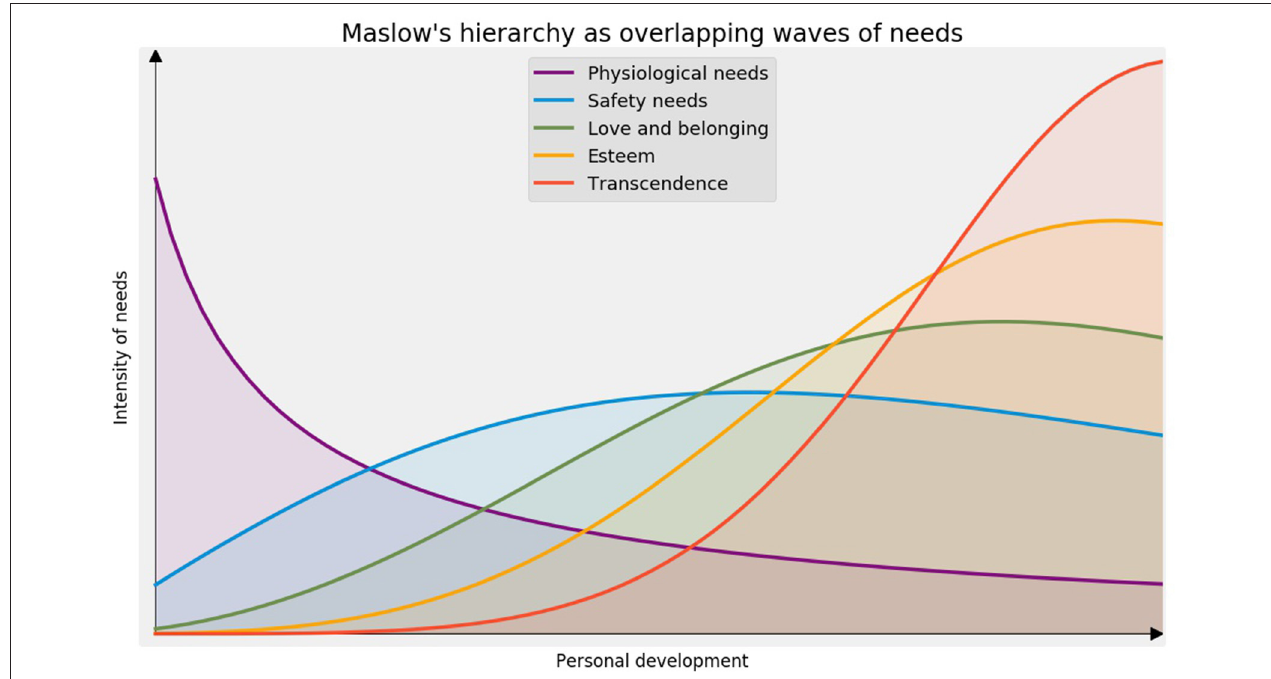
FIGURE 2 | A dynamic depiction of Maslow’s hierarchy as overlapping waves of